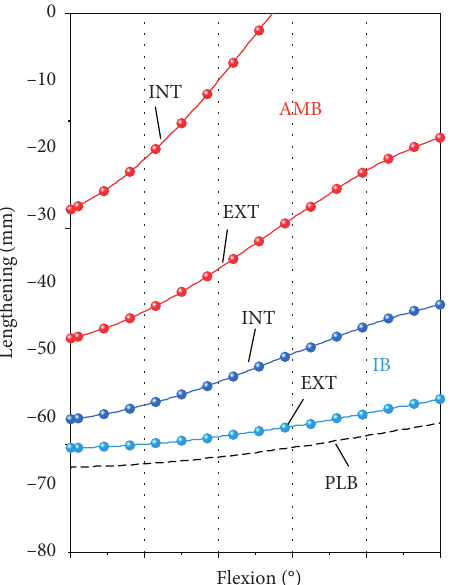
Figure 3: Mean length change patterns for the three ACL bundles during flexion, in internal (INT) and external (EXT) tibial rotation after surgical treatment of anterior cruciate ligament